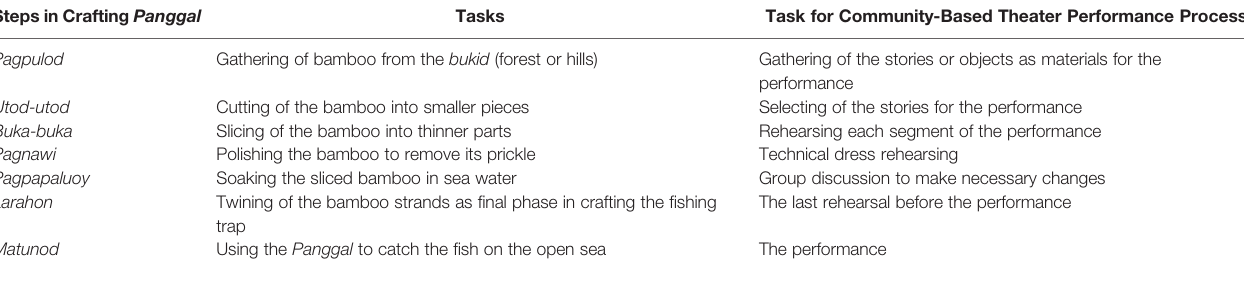
TABLE 1 | Panggal-as-Performance Method in Community-based Theater Performance creation. Steps in Crafting